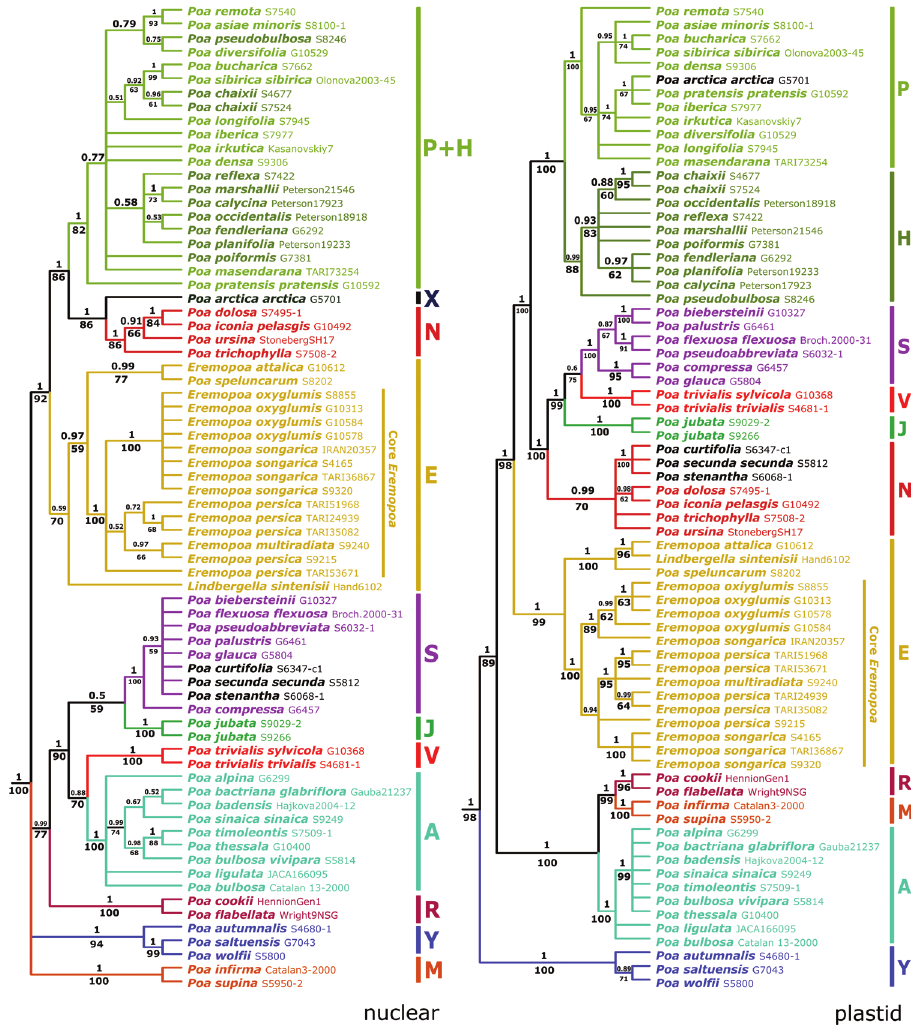
Figure 1. Poa nrDNA and plastid Baysian analyses showing placement of Eremopoa and Lindbergella . Bayesian 50% majority rule consensus trees of nrDNA ITS and ETS (left) and plastid data ( trnT - trnL - trnF , matK and rpoB - trnC ) (right). Bayesian posterior probabilities are shown above branches, MP boot- strap values below branches. Outgroups are not shown. Major clades are indicated by colour and capital letter. Taxa shown in black belong to different major clades in plastid and nrDNA